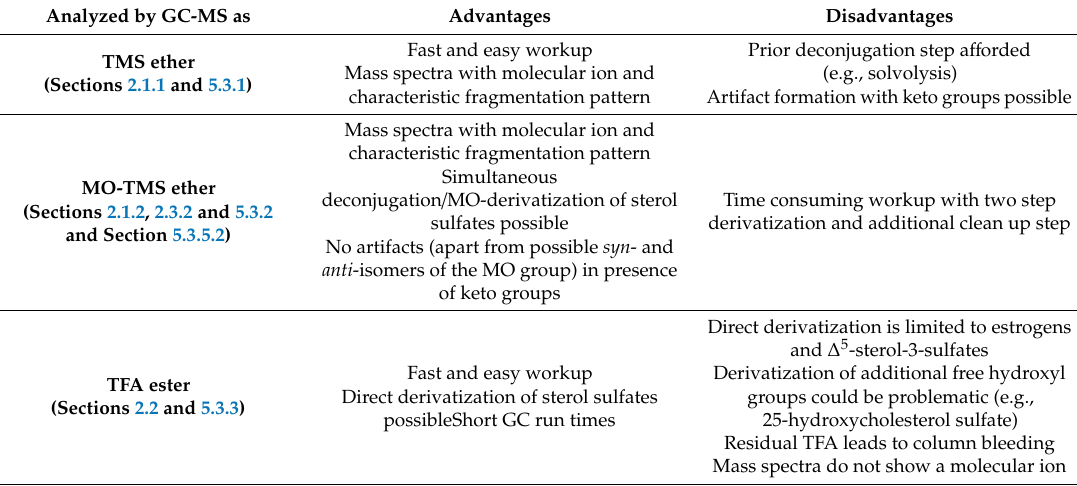
Table 1. Overview of derivatization methods for analysis of sterol sulfates. Analyzed by GC-MS as Advantages Disadvantages Prior deconjugation step a ff orded Fast and easy workup TMS ether (e.g., solvolysis) Mass spectra with molecular ion and (Sections 2.1.1 and 5.3.1) characteristic fragmentation pattern Artifact formation with keto groups possible Mass spectra with molecular ion and characteristic fragmentation pattern Simultaneous MO-TMS ether Time consuming workup with two step deconjugation / MO-derivatization of sterol (Sections 2.1.2, 2.3.2 and 5.3.2 derivatization and additional clean up step sulfates possible and Section 5.3.5.2) No artifacts (apart from possible syn - and anti -isomers of the MO group) in presence of keto groups Direct derivatization is limited to estrogens and ∆ 5 -sterol-3-sulfates Derivatization of additional free hydroxyl Fast and easy workup TFA ester groups could be problematic (e.g., Direct derivatization of sterol sulfates (Sections 2.2 and 5.3.3) 25-hydroxycholesterol sulfate) possibleShort GC run times Residual TFA leads to column bleeding Mass spectra do not show a molecular